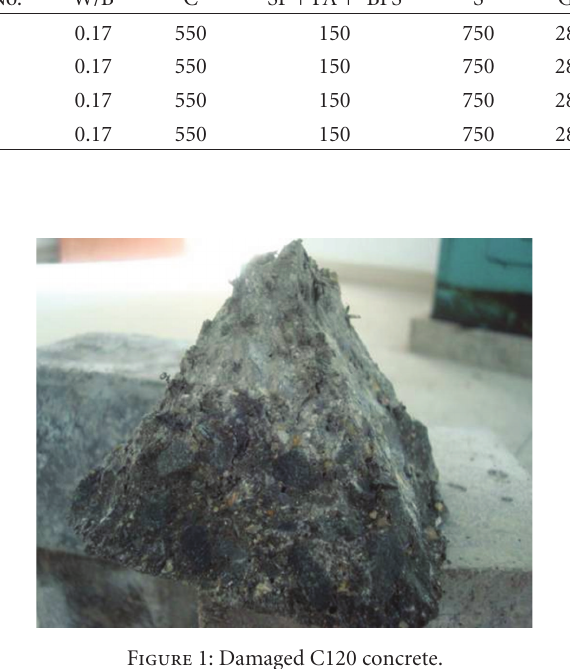
Figure 4: P-CMOD for basic concrete.